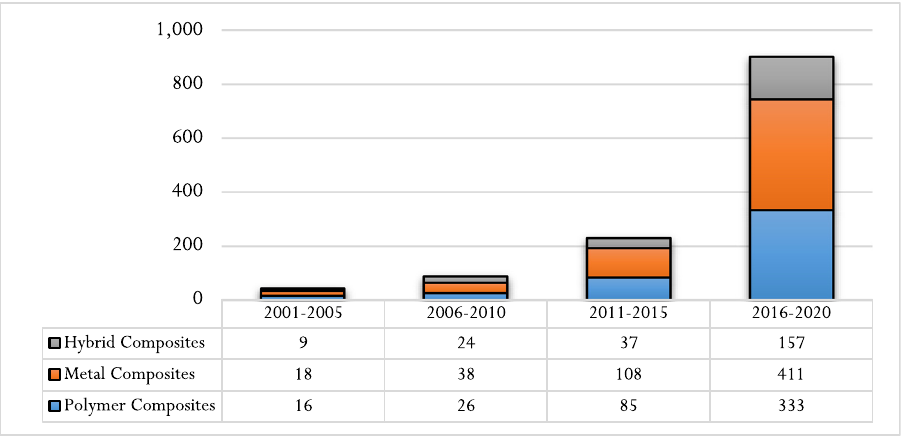
Figure 2: Mapping of ES waste utilization for composite development. The graph is compiled and summarized based on the search data in [ 32 ]